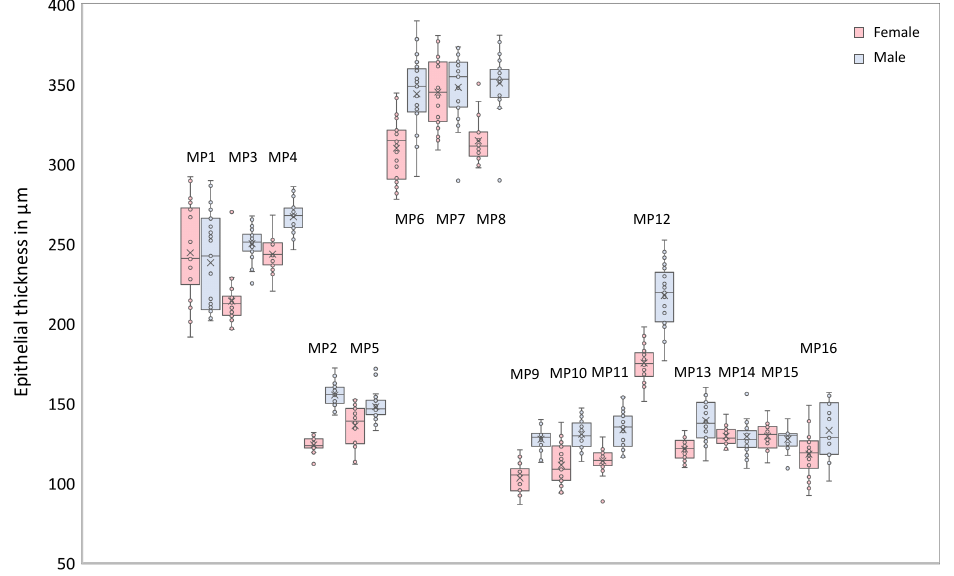
Figure A1. Box plot of the gender- and age-specific epithelial thickness of selected distinctive measurement points. Labial: MP4, Alveolar: MP5, Buccal: MP7, Sublingual: MP9, Hard palate: MP12, Soft palate: MP13 (cp. Figure 1).